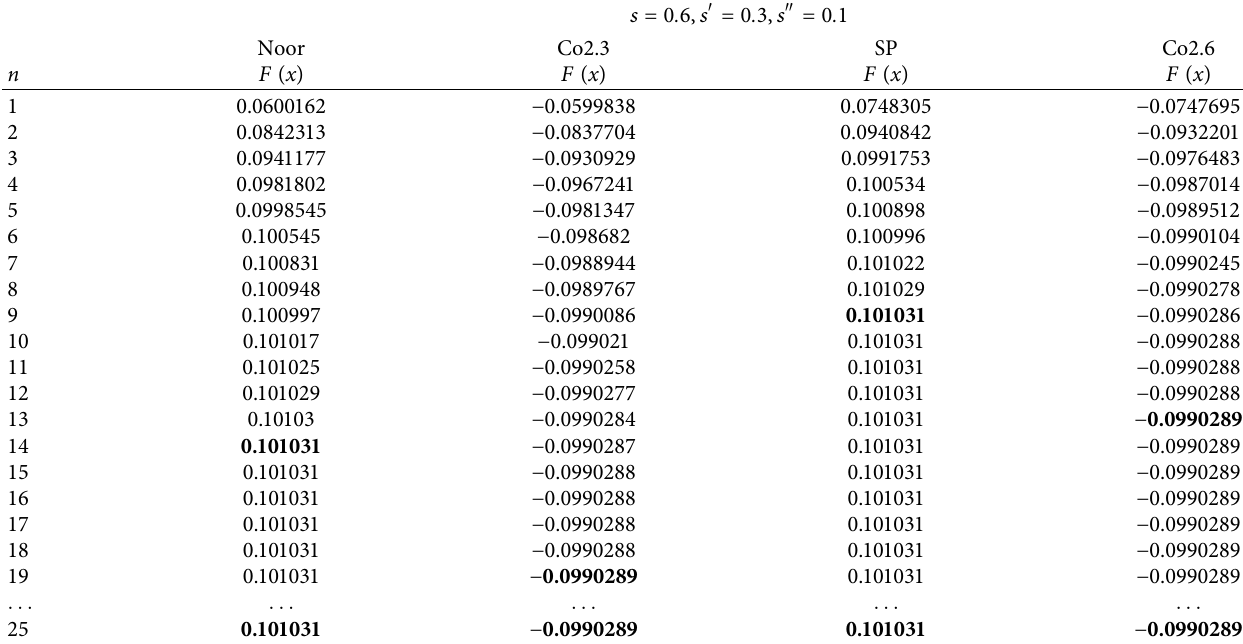
Table 3: Iterations of cubic function s � 0 . 6 ,s ′ � 0 . 3 , s ″ � 0 .